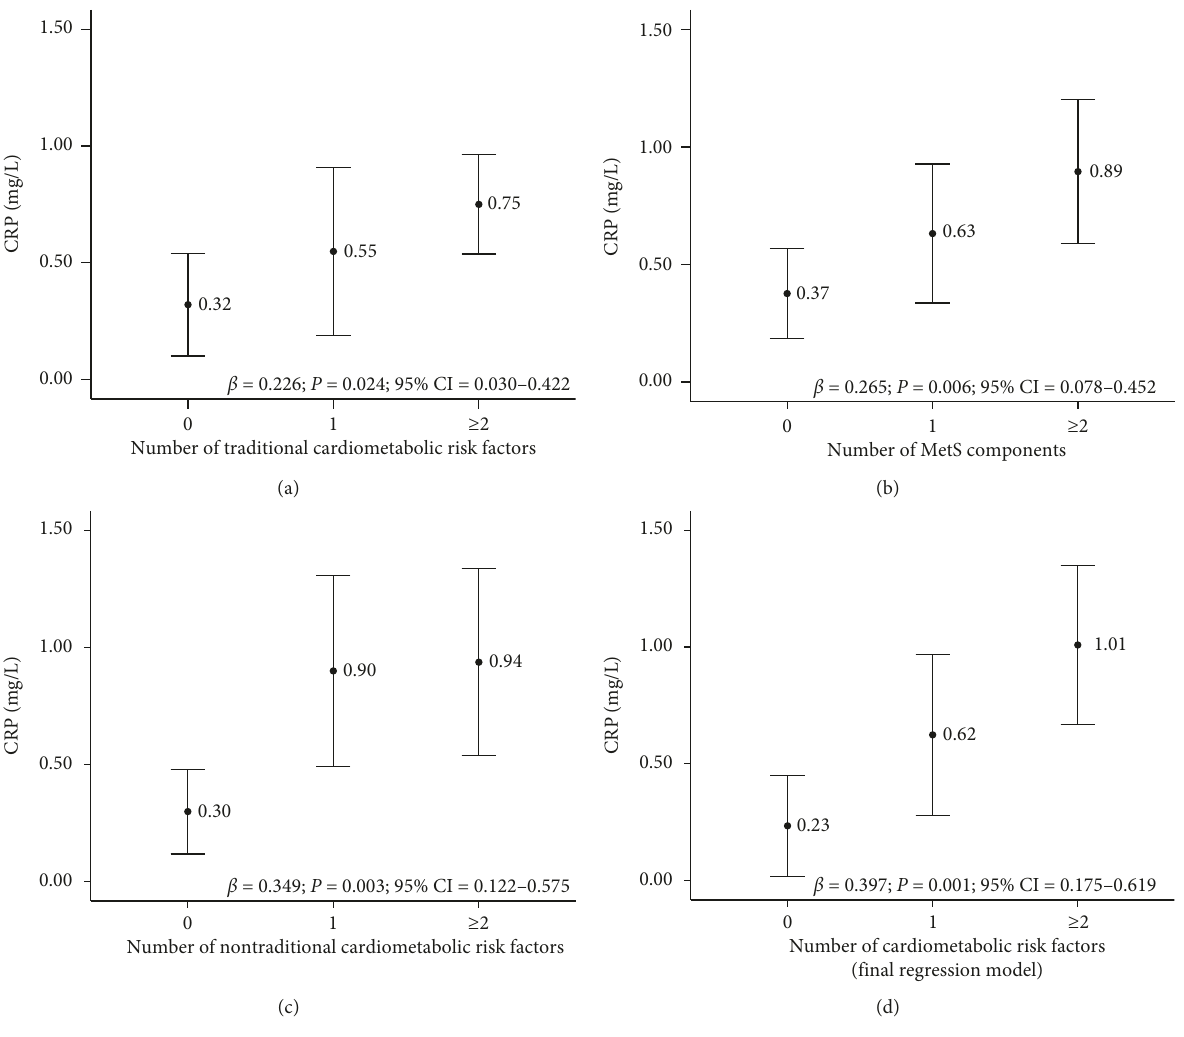
Figure 1: Mean serum hs-CRP concentration (dependent variable) according to the accumulation of altered (a) traditional cardiometabolic risk factors, (b) metabolic syndrome components, (c) nontraditional cardiometabolic risk factors, and (d) risk factors from the final regression model in children, Viçosa, MG, Brazil, 2015. Multiple linear regression ( ∗ P < 0 . 05) adjusted for age, sex, ethnicity, income, and sedentary